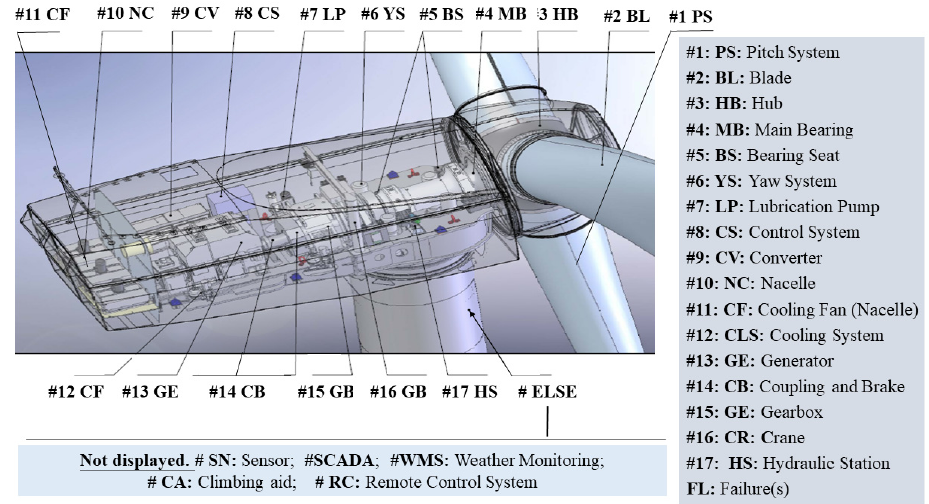
Figure 2. A representative configuration of a wind turbine.